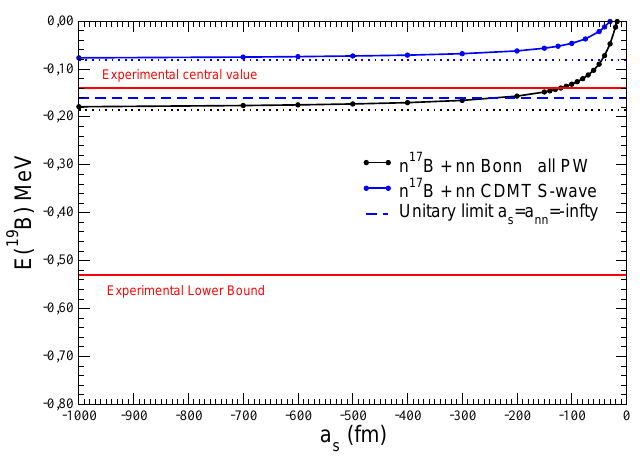
Figure 7: 19 B ground-state energy with respect to the first particle threshold as a function of a , for R = 3 S